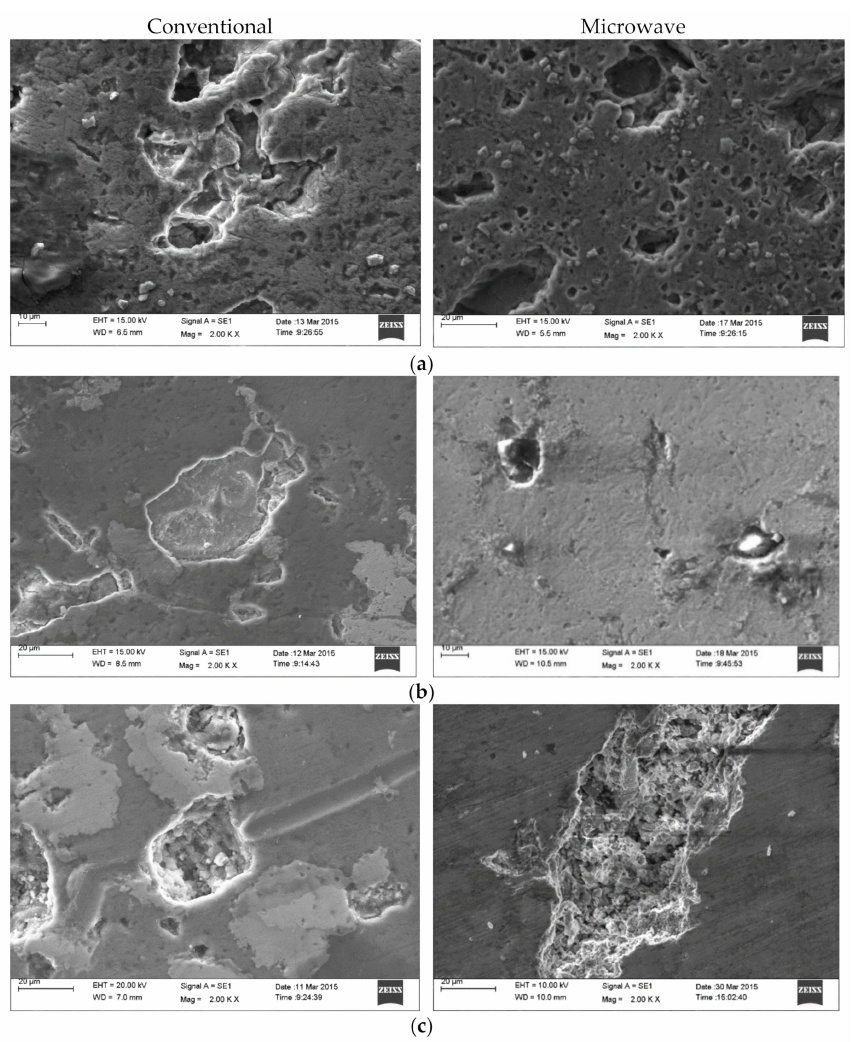
Figure 3. SEM microstructure of Aluminum compacts of ( a ) Al-22.5%Mn; ( b ) Al-18.6%Cu-24.12%Mn; ( c ) Al-20%Cu-15%Mn sintered in conventional furnace (left) and microwave furnace